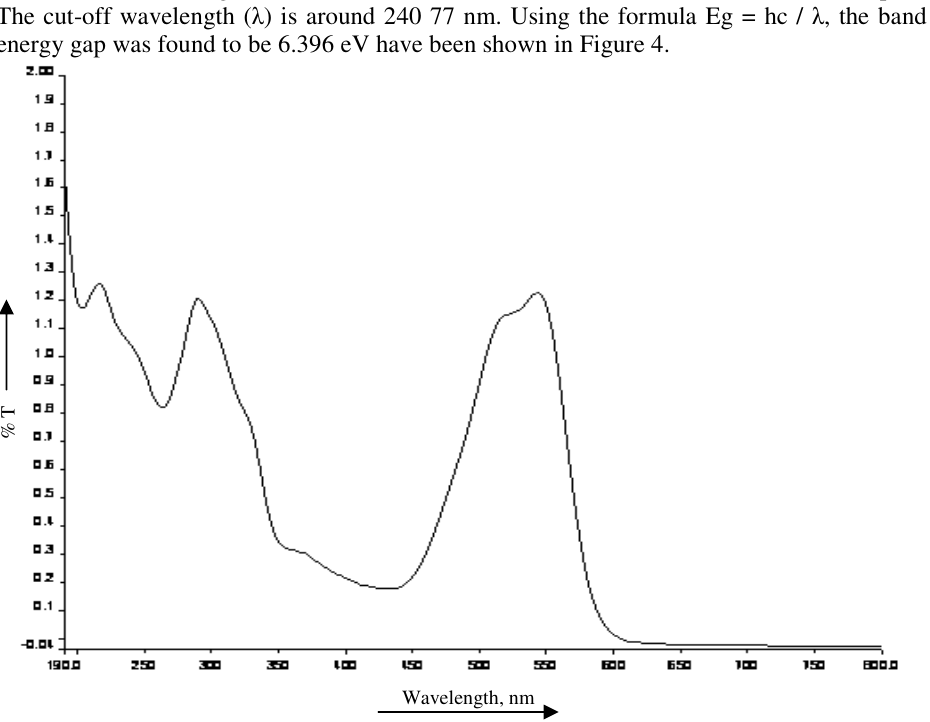
Figure 4. UV-visible transmittance spectrum for 7-bromo-6-chloro-3-[3-[(2 R ,3 S